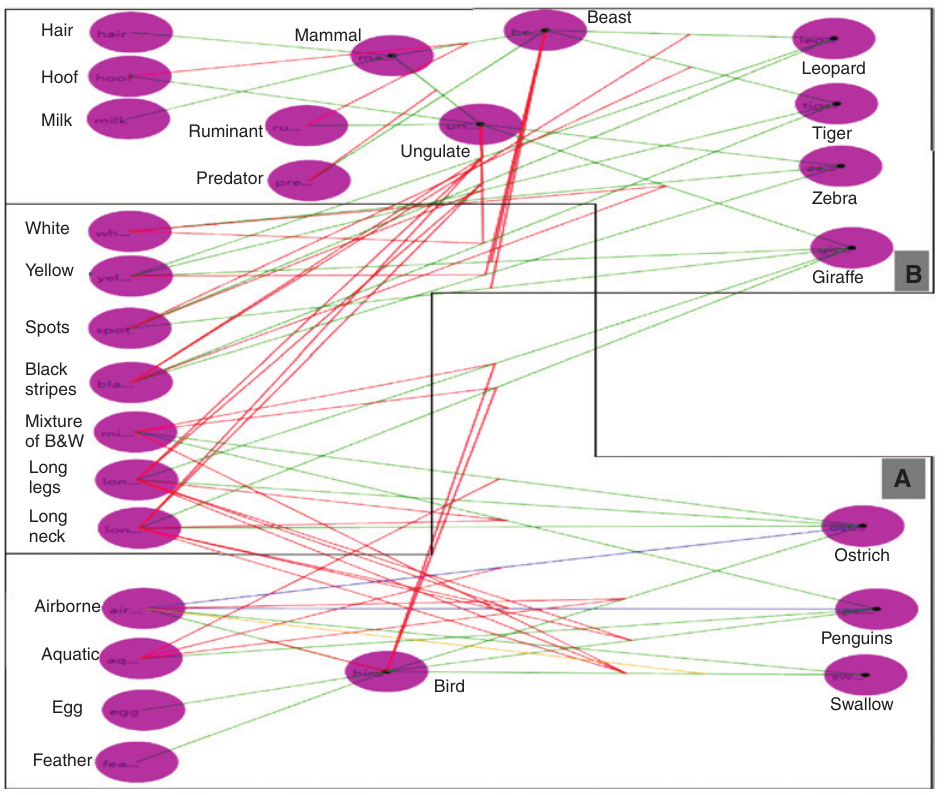
Figure 7: Demo: Network Structure of PLDNN to Represent Logical Relations of Animals and Their